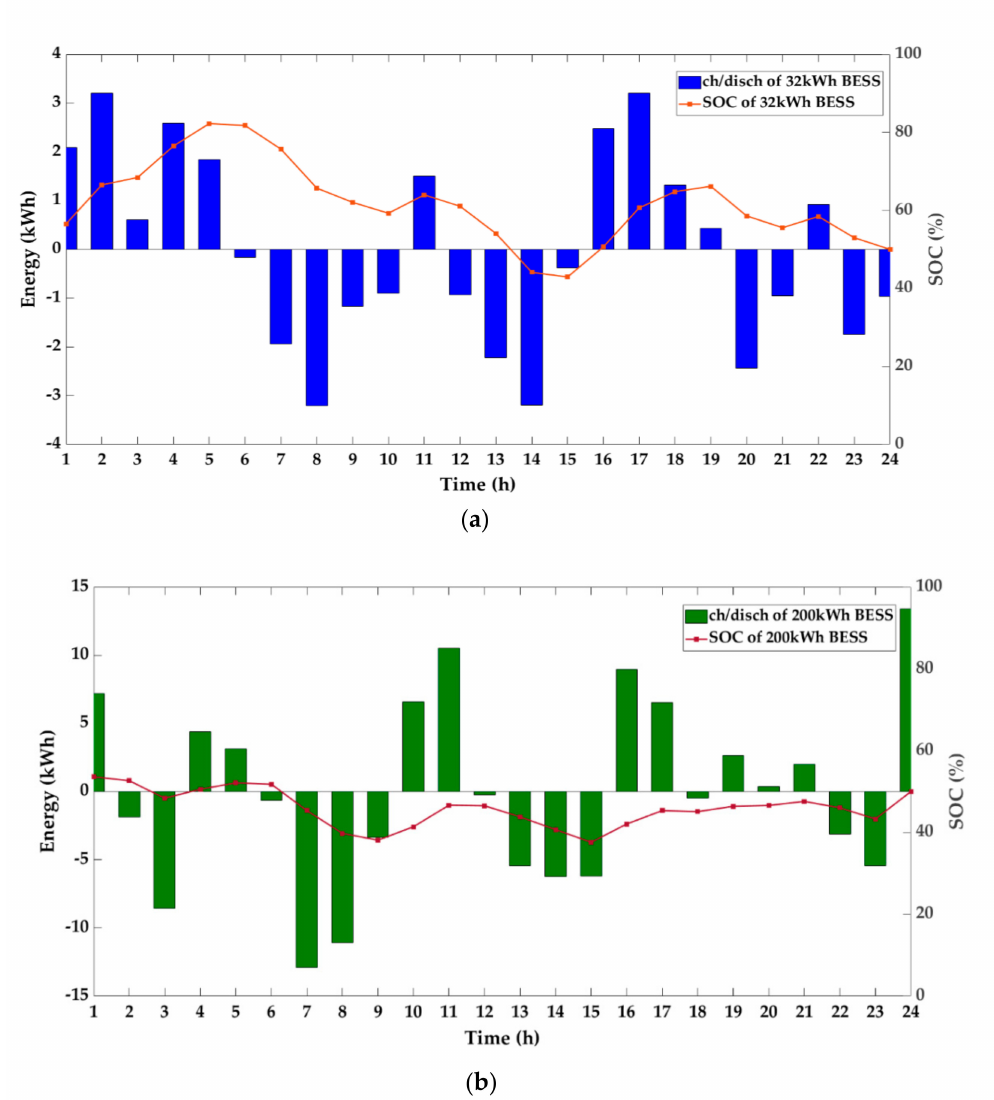
Figure 6. Optimal charging/discharging cycles and state of charge (SOC) of BESS. ( a ) 32 kWh BESS. ( b ) 200 kWh